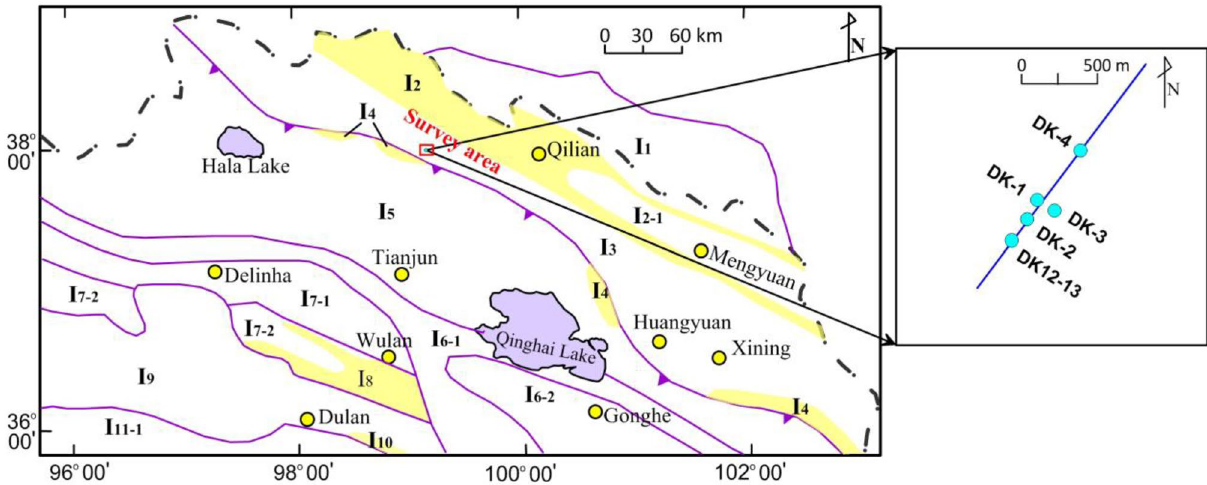
Figure 1. Schematic diagram of structures within the study area overlaid on an aerial photograph. I 1 represents the Alxa landmass; I 2 represents the Northern Qilian neo-Proterozoic to early Paleozoic suture zone. I 2-1 represents the Qilian-Menyuan magmatic arc zone, middle and late early Paleozoic (O-S). I 3 represents the Qilian block in the center. I 4 represents the Suture zone between Shule Nanshan and Laguiyama in the Early Paleozoic. I 5 represents the Southern Qilian’s landmass. I 6 represents the Late Paleozoic-Early Mesozoic Fracture Trough (D-T2) at ZongwuLongshan-Qinghai Nanshan. I 6-1 represents the Zongwu Longshan-Xinghai Aola Trough (D-P). I 6-2 represents the Post-Foreland Basin of the Zeku Arc (T 1-2 ). I 7 represents the Oulongbrook Land Block. I 7-1 represents the Orbo Mountain, Craton Edge Basin. I 7-2 : T-shaped VI-Amunik Mountain- Depleted Late Neoproterozoic Niushan Magma Arc Belt (Pt 3 -S). I 8 represents the ChaiBei Rim’s Suture Zone. I 9 represents the Qaidam’s Plot. I 10 represents the Qimantag-Dulan Suture Zone. I 11 represents the Dongkun Middle Land Block. I 11-1 represents the Dongkun Middle Magma Arc Zone (Pt 3 -J). The blue dots in the box on the right represent the drilling wells within the survey area (Modified from Lu et al. 7 , 2010. Map created in Surfer 14.0.599 of Golden Software, LLC (https:// www. golde nsoft ware. com/ produ cts/